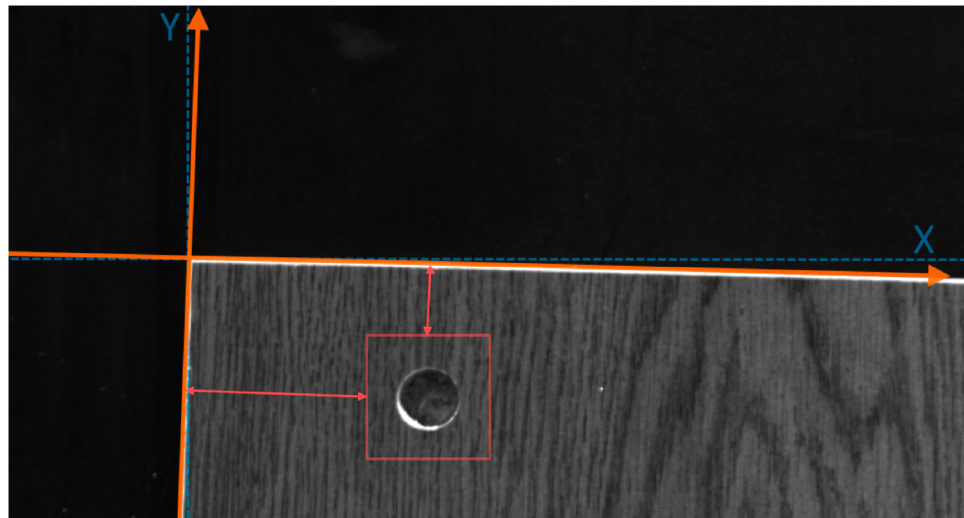
Figure 16. Furniture panel reference point and coordinate systems. The rotation of the object is evaluated and the coordinates system is turned accordingly. The hole drilling segmentation region is offset from the reference point by the given distance.